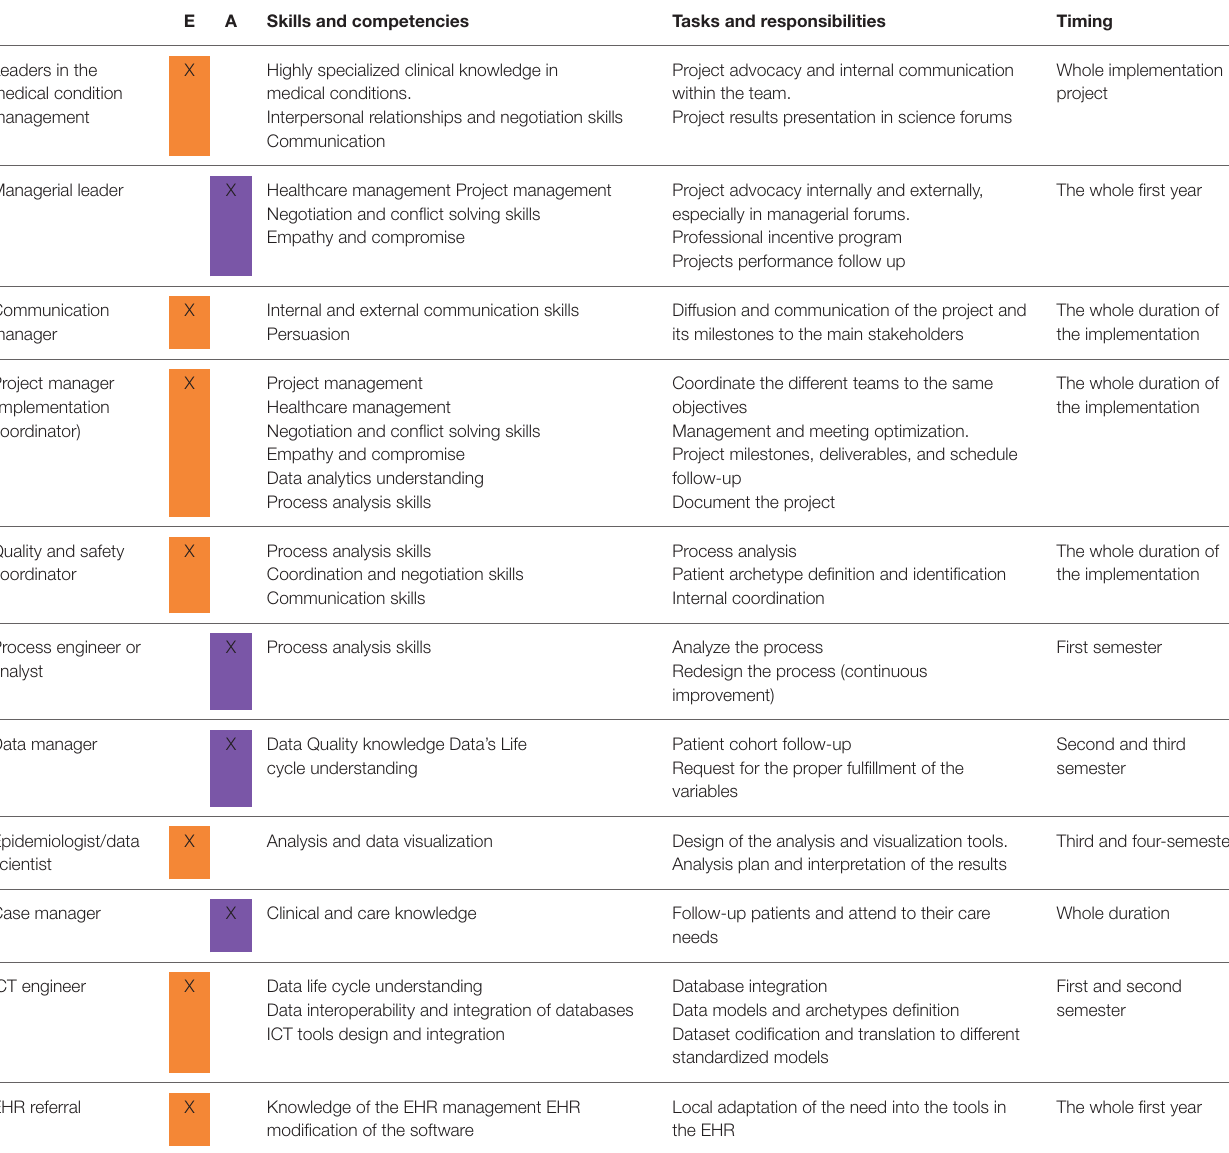
TABLE 2 | Professional profiles and competencies, skills and responsibilities; E, essential; A, advisable. Skills and competencies Tasks and responsibilities